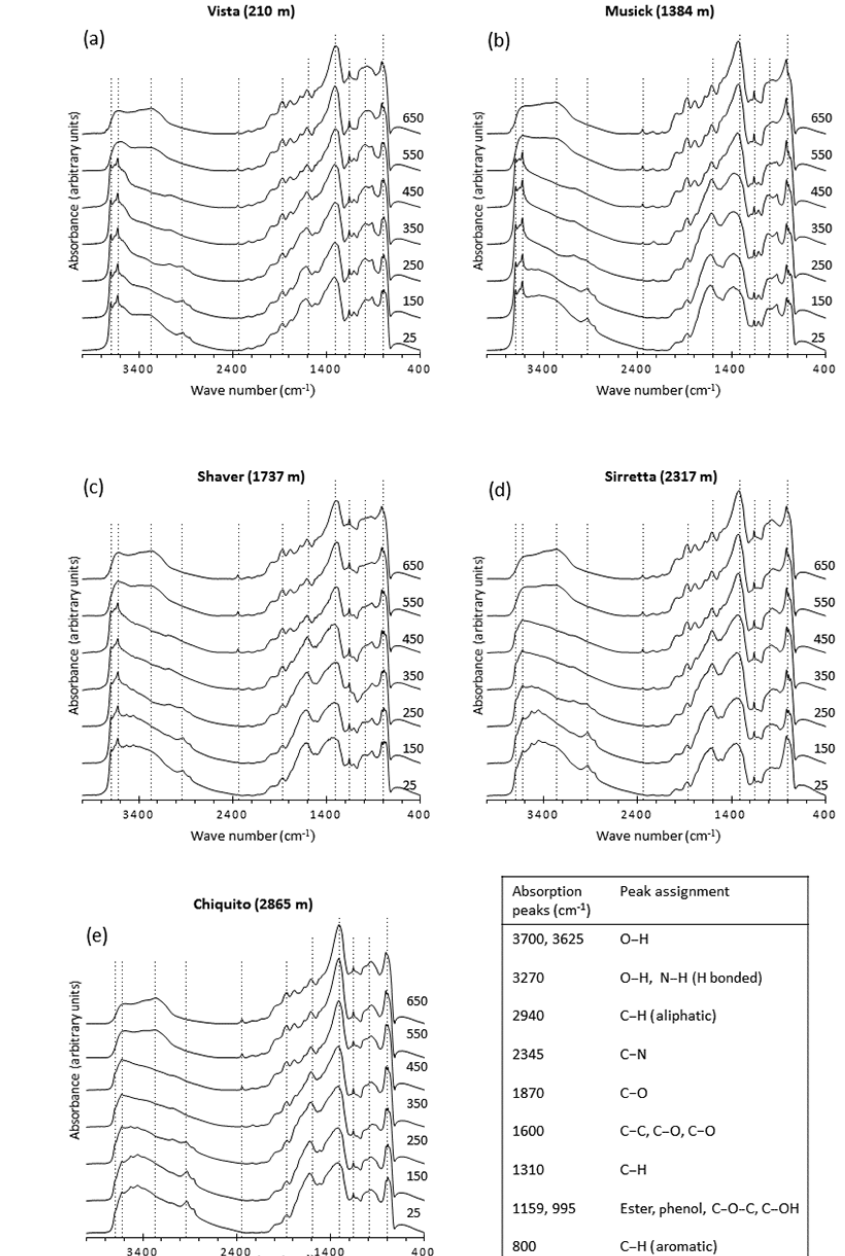
Figure 5. FTIR spectra of the five soils at the different heating temperatures. Heating temperatures, in Celsius, are shown to the right of each